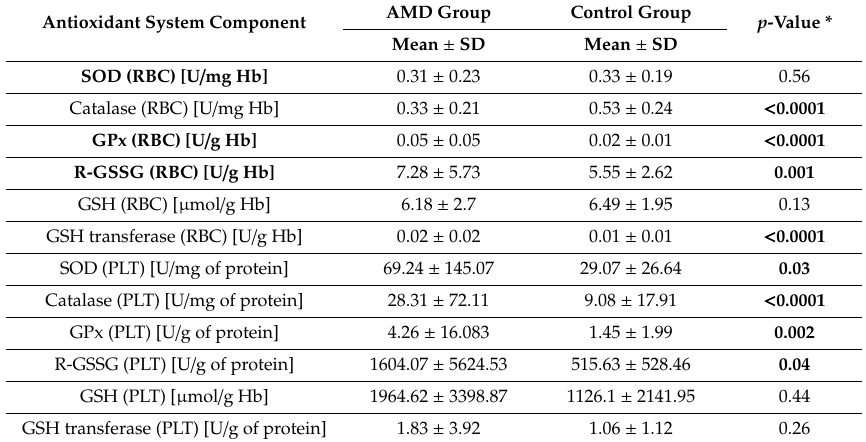
Table 4. Comparison of levels of components of the antioxidant system in patients with AMD and controls. The bold font indicates p -values < 0.05, which were considered statistically significant.